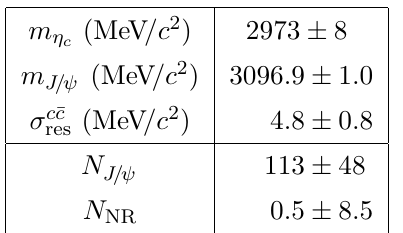
! p (cid:22) p(cid:25) + (cid:25) (cid:0) can- s